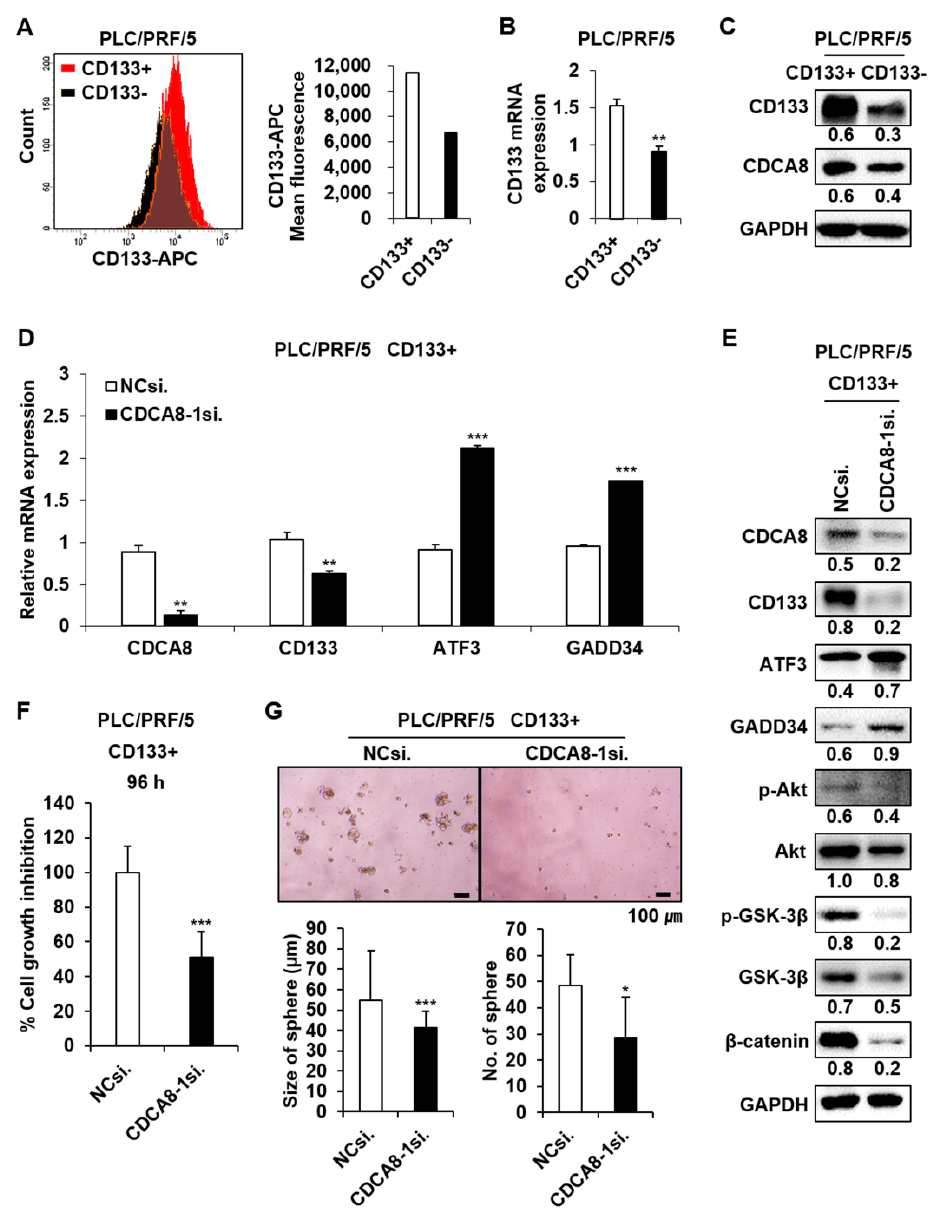
Figure 8. Targeting CDCA8 reduces CD133 expression and inhibits growth and spheroid formation in the CD133 + PLC/PRF/5 cell population. ( A ) Isolation of the CD133 + population from the PLC/PRF/5 parental cell culture. ( B ) Relative level of CD133 mRNA between CD133 + and CD133 − cell population. ( C ) Relative levels of CD133 and CDCA8 proteins between CD133 + and CD133 − cell populations. ( D ) Changes in mRNA expression of the indicated genes in the CD133 + population treated with CDCA8-1siRNA. ( E ) Changes in the levels of the indicated proteins in the CD133 + population treated with CDCA8-1siRNA. ( F , G ) Inhibition of growth ( F ) and spheroid formation ( G ) in the CD133 + population treated with CDCA8-1siRNA. * p < 0.05; ** p < 0.01; *** p < 0.001 vs. control. Scale bar = 100 µ